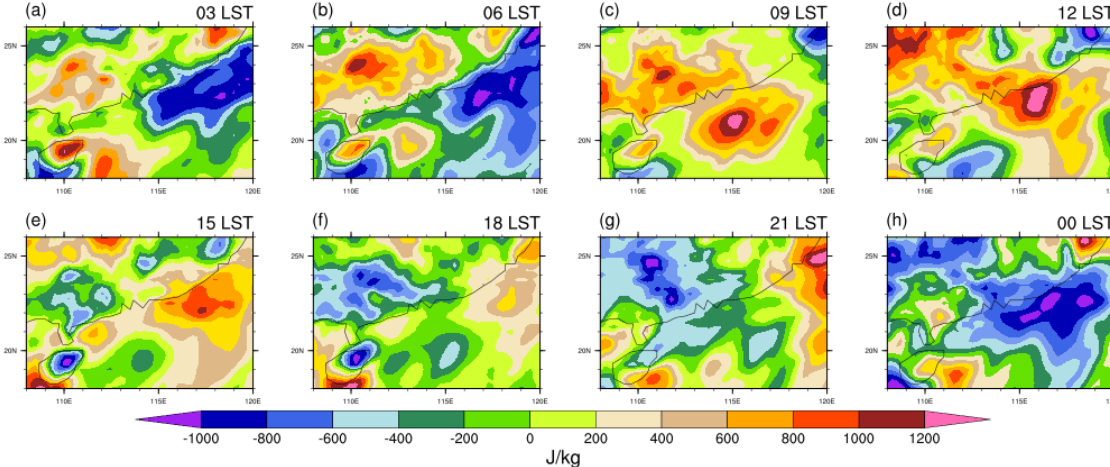
Figure 13. Same as in Figure 12 but for the vertical moist stability anomaly.